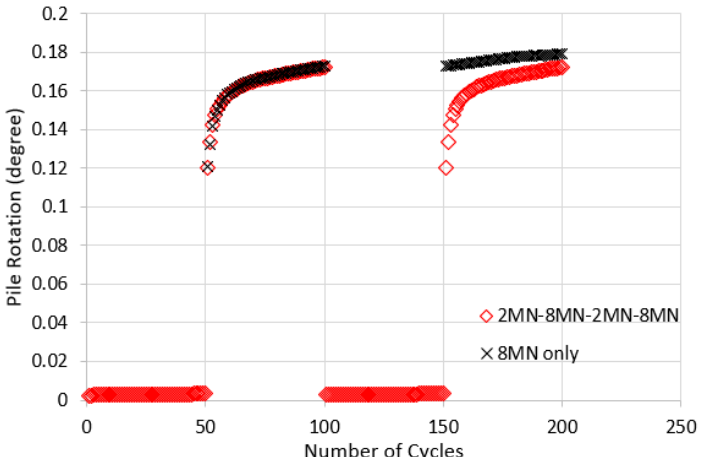
Figure 16. The cumulative rate of rotation for the single amplitude and multi-amplitude